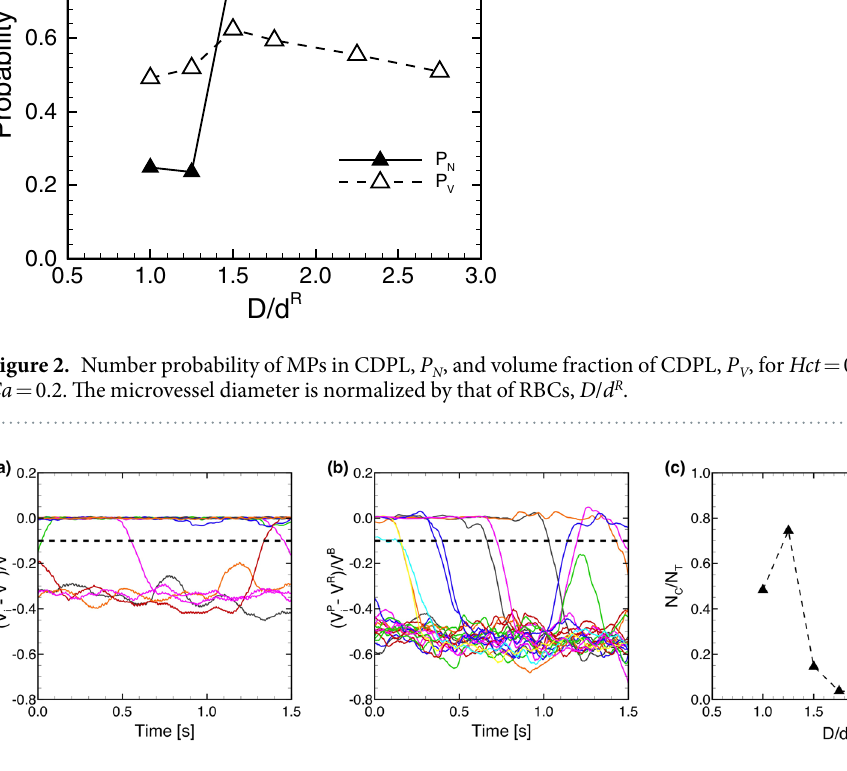
Figure 3. Time history of relative velocity ratio, − V V V ( )/ iP R B for ( a ) D = 10 μ m (18 MPs), and ( b ) 12 μ m (24 MPs), where moving-average velocity of each particle ( V ip ) relative to mean RBC velocity ( V R ) is normalized by the whole blood velocity ( V B ). The moving-average was conducted for a time period of 0.2 s. Dotted line represents the capture threshold, − V V V ( )/ iP R B = − 0.1. ( c ) Capture ratio of MPs, where N C is the number of captured MPs and N T is the total number of